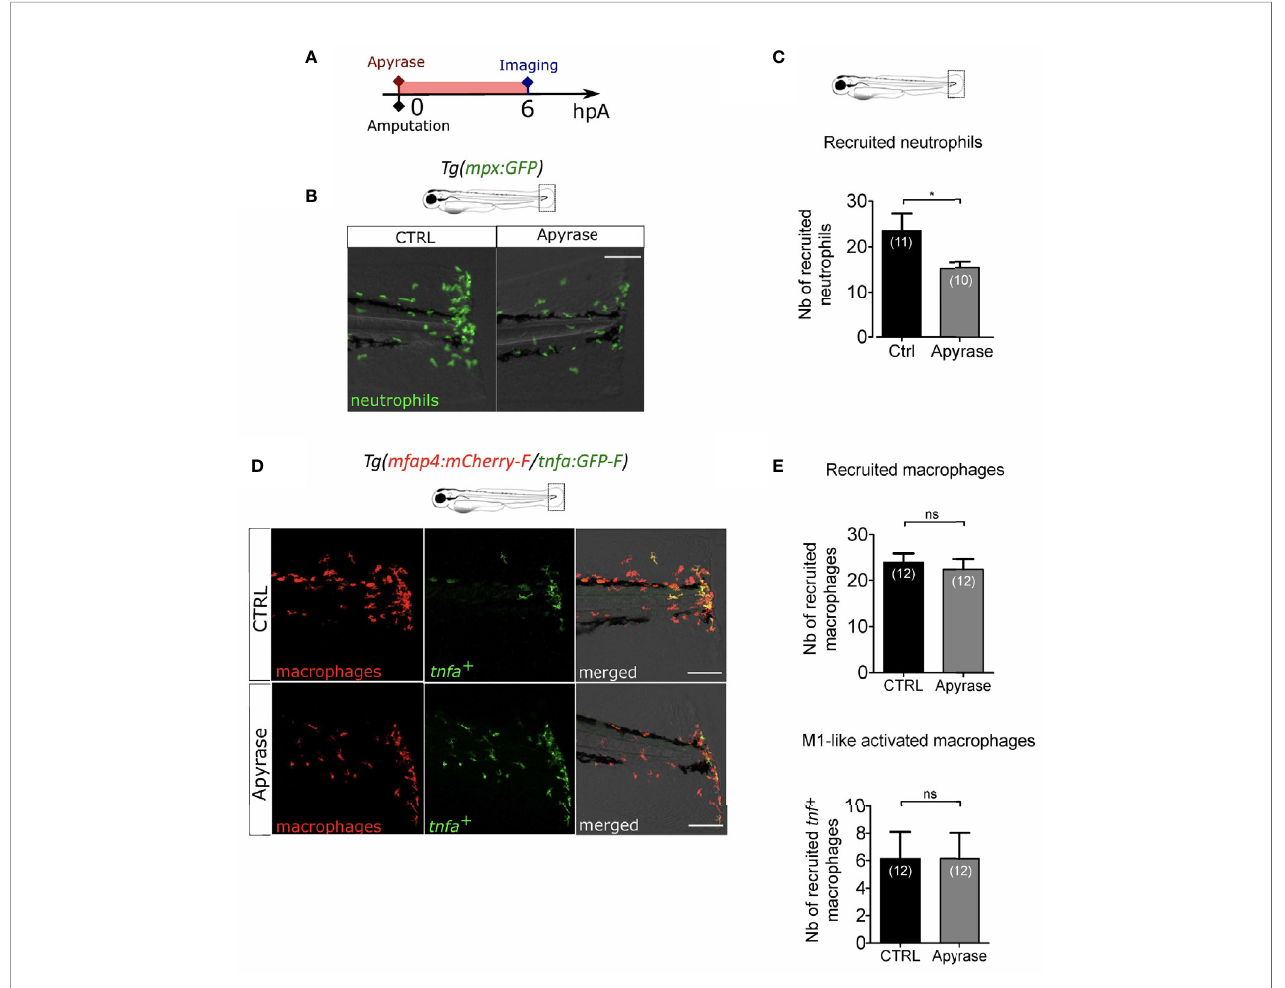
FIGURE 5 | Extracellular ATP is not necessary for macrophage activation. (A) Schedule of the experiment. Fin folds from Tg(mpx:GFP) or Tg(mfap4:mCherry-F/tnfa: GFP-F) were injured at 3 dpf and larvae were immediately incubated in zebra fi sh water containing or not Apyrase and imaged at 6 hpA using epi- fl uorescent or confocal microscopy. (B) Tail images are representative overlays of GFP fl uorescence (neutrophils) and bright fi eld image. Images were acquired at 6 hpA by epi- fl uorescent microscopy from Tg(mpx:GFP) larvae either untreated or treated with Apyrase. Scale bar: 100 m m. (C) Quanti fi cation of neutrophils recruited at the wound at 6hpA. Representative experiment of two independent experiments, mean ± SEM, n larvae is indicated in brackets, one-tailed t-test with Welch ’ s correction, *p<0.05. (D) Tail images are representative maximum projections of the fl uorescence of mCherry-F (macrophages), GFP-F ( tnfa+ cells) and merged channel